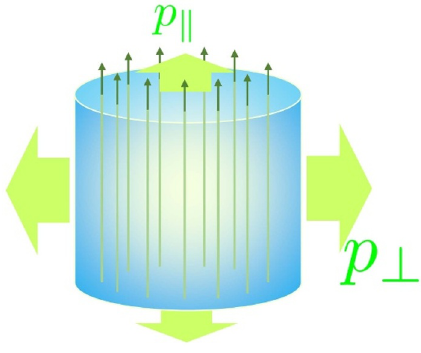
Figure 1 . Pressure anisotropy in the local thermal equilibrium state with the magnetic flux (green thin arrows). The relative magnitude depends on the product of the magnetic flux B and magnetic field H